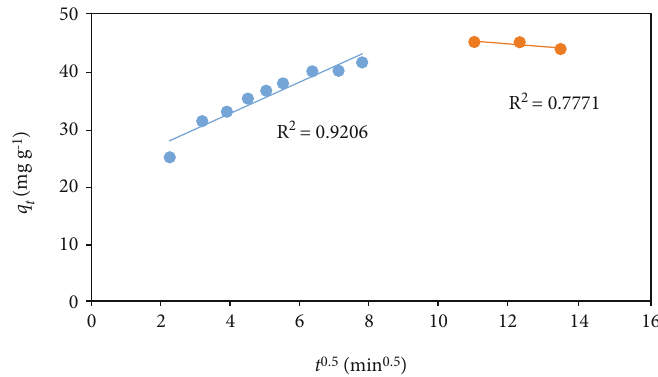
Figure 6: Weber-Morris